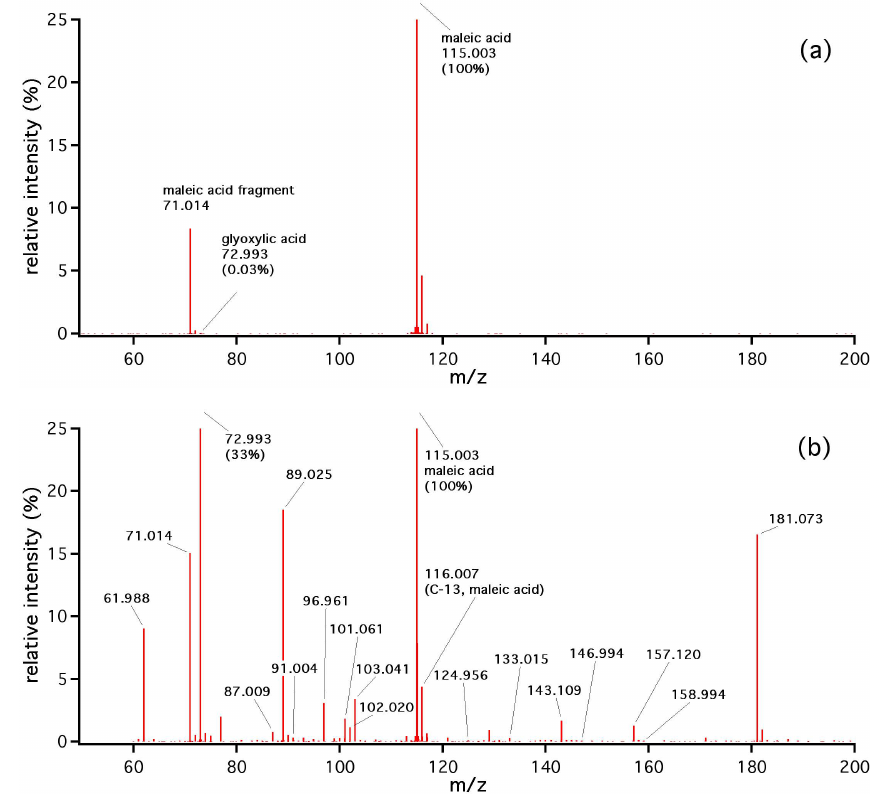
Fig. 2. Mass spectra of the reaction products of the aerosol phase reaction of ozone with maleic acid aerosol in a 50l reaction barrel. Reaction time between ozone and aerosol was approximately 7.5h. The dry reaction was conducted at < 5% RH (a) . The wet reaction was conducted at 90% RH (b) . Post reaction the processed aerosol was collected on a Teflon filter and extracted from the filter in pure